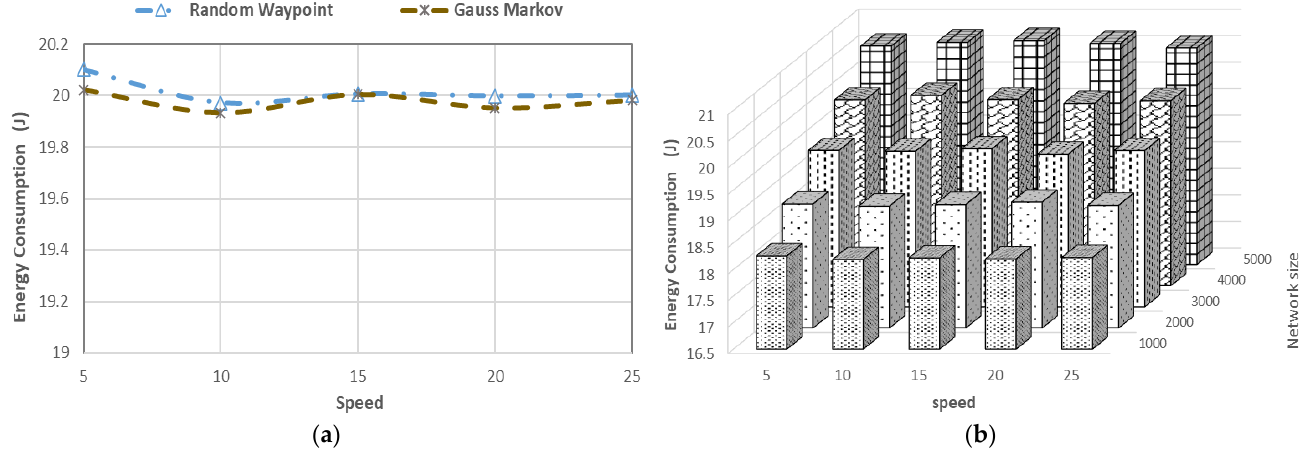
Figure 7. Energy consumption: ( a ) average energy consumption per end device for a network with 2000 × 2000 area, 4000 devices, and 60 B payload across different speeds in m/s; ( b ) average energy consumption per end device for a network with 2000 × 2000 area using the random waypoint mobility model, with 20 B payload across different speeds in m/s.